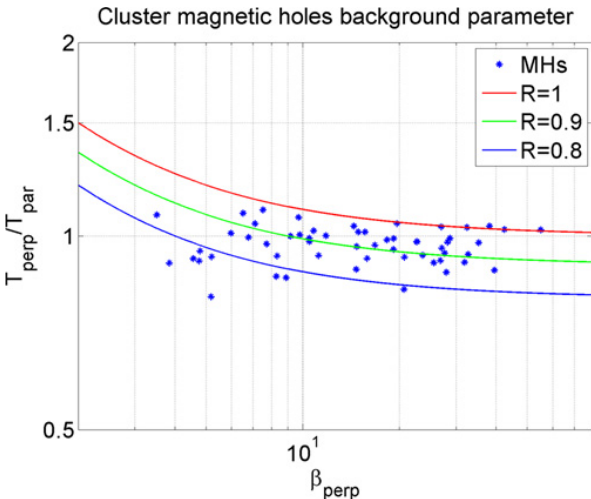
Fig. 6. The distributions of the temperature anisotropy ( T ⊥ /T // ) and β ⊥ for magnetic holes observed by Cluster. The red line, green line, and blue line represent R = 1, R = 0 . 9, and R = 0 . 8, respec- tively. We use their background temperatures and magnetic fields to calculate the T ⊥ / T // and β ⊥